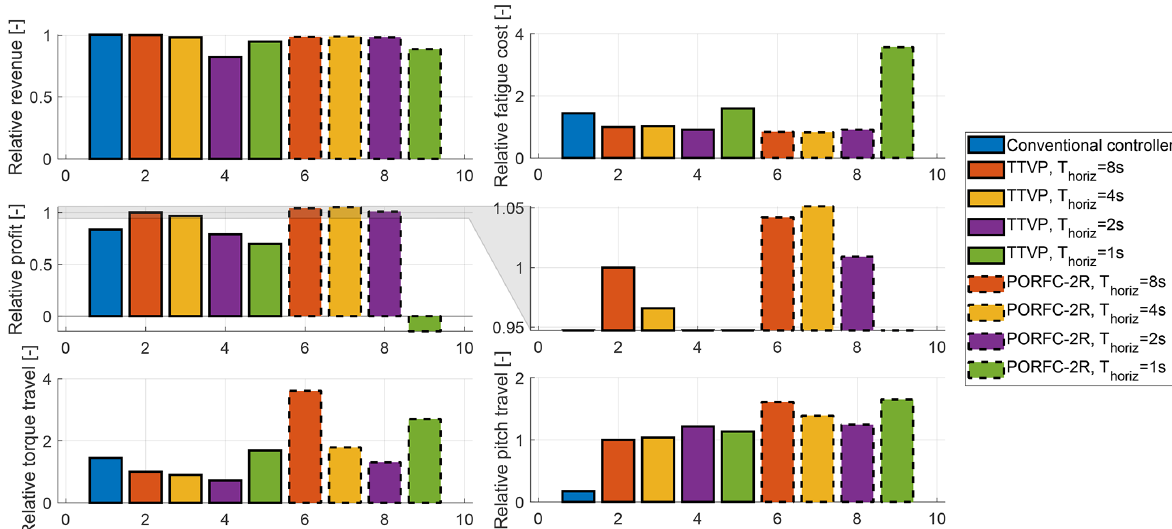
Figure 12. “High decay lidar” scenario. Weibull-weighted KPIs for different controller formulations and prediction horizon lengths. Results are normalized with respect to the best TTVP configuration with a prediction horizon length of T horiz = 8s. Middle row, right: zoomed version of profit